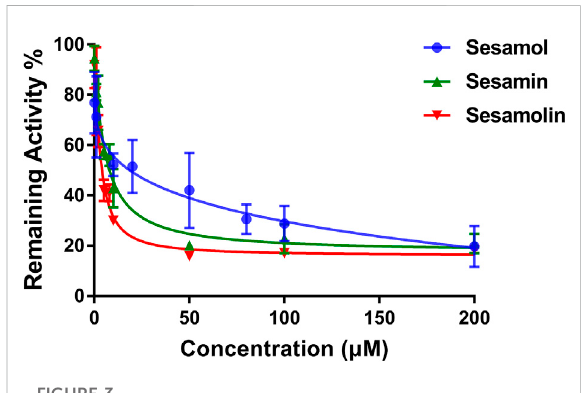
FIGURE 3 Dose-response inhibition curves of sesamol, sesamin, and sesamolin against human CYP46A1 using testosterone as the substrate. Results were shown as the mean ± SD of three